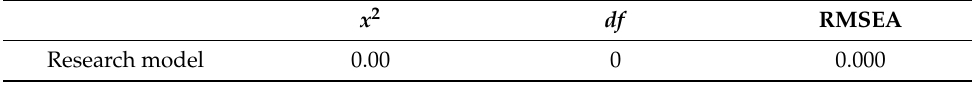
Table 3. Goodness of fit index of path analysis of taekwondo level, GRIT, and GPA.